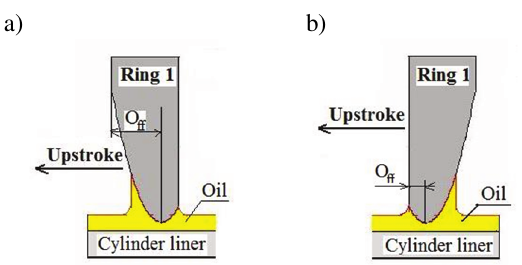
Table 1. Main data of the marine engine under consideration [14] Cylinder bore 960 mm Piston stroke Engine rotational speed 102 rpm